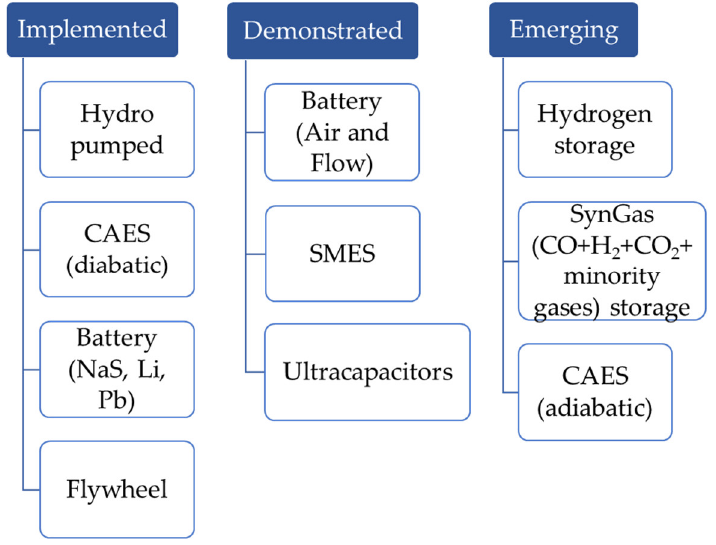
Figure 3. Energy Storage Technologies: Classification according to mature technology.